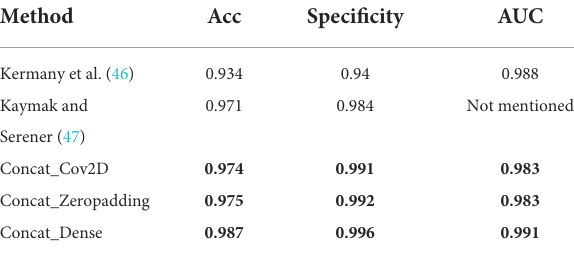
TABLE 9 Comparison of different methods on external